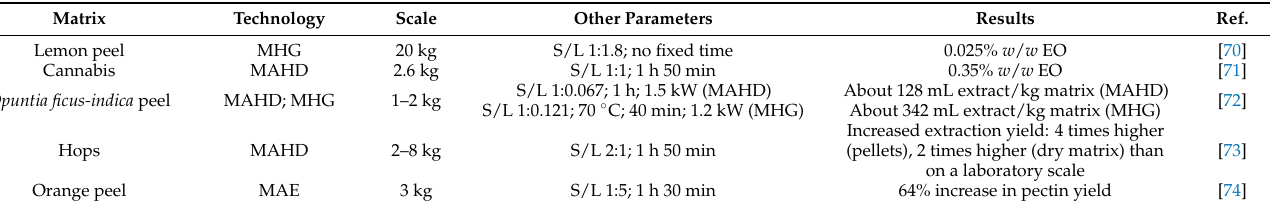
Table 2. Studies on pilot scale MAE, from 2017 to